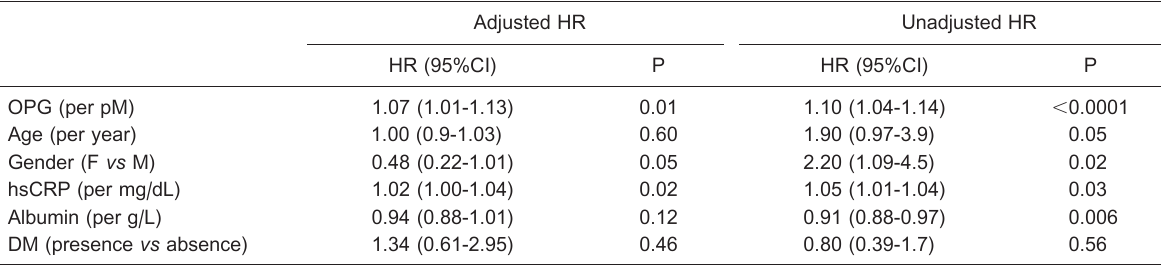
Table 5. Cox regression analysis for osteoprotegerin (OPG) levels regarding all-cause of mortality in 145 patients with chronic kidney disease stages 3 to 5.